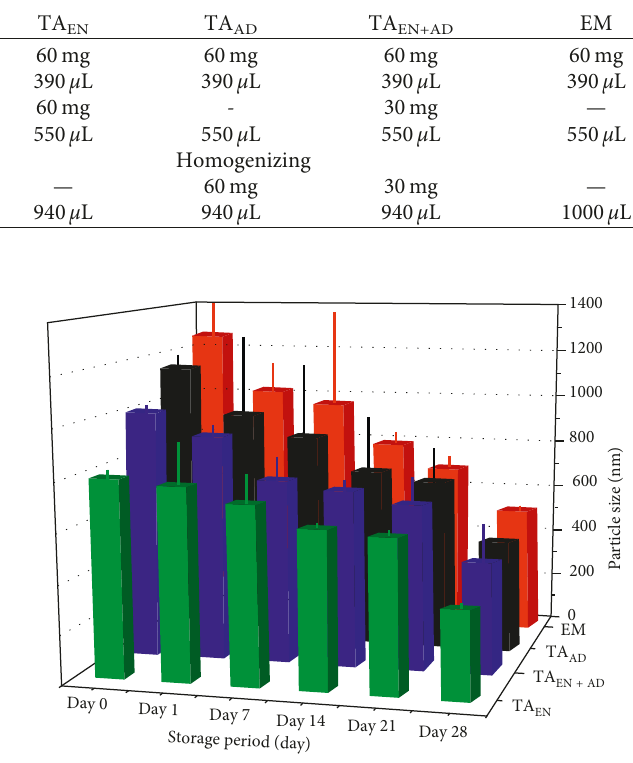
Figure 1: Particle sizes of the four emulsion formulations at various time points in the storage period (mean ± standard de- viation, n � 3).